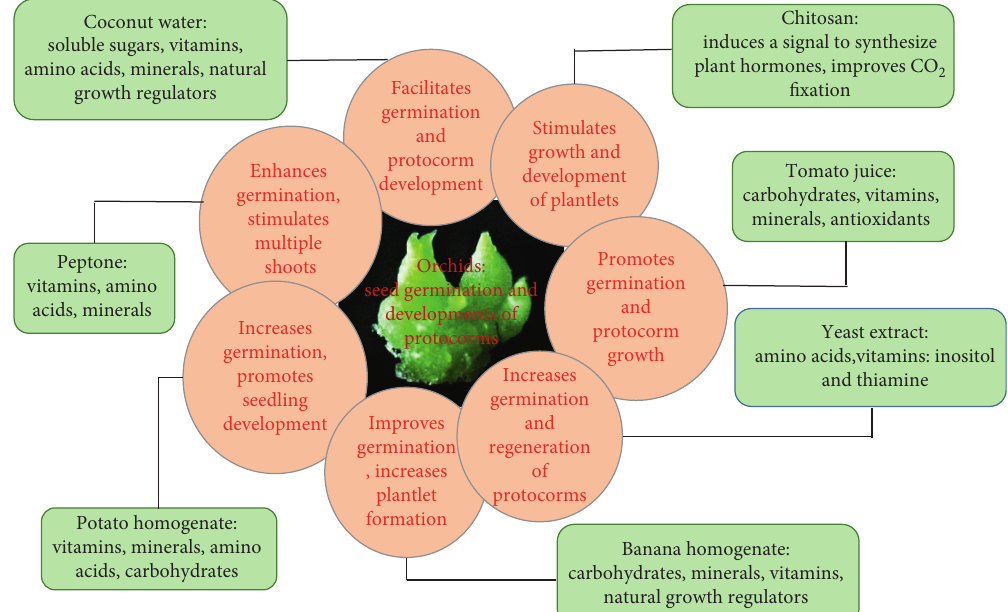
Figure 1: Overview on the contents and roles of some organic supplements in seed germination and further development of the protocorm in